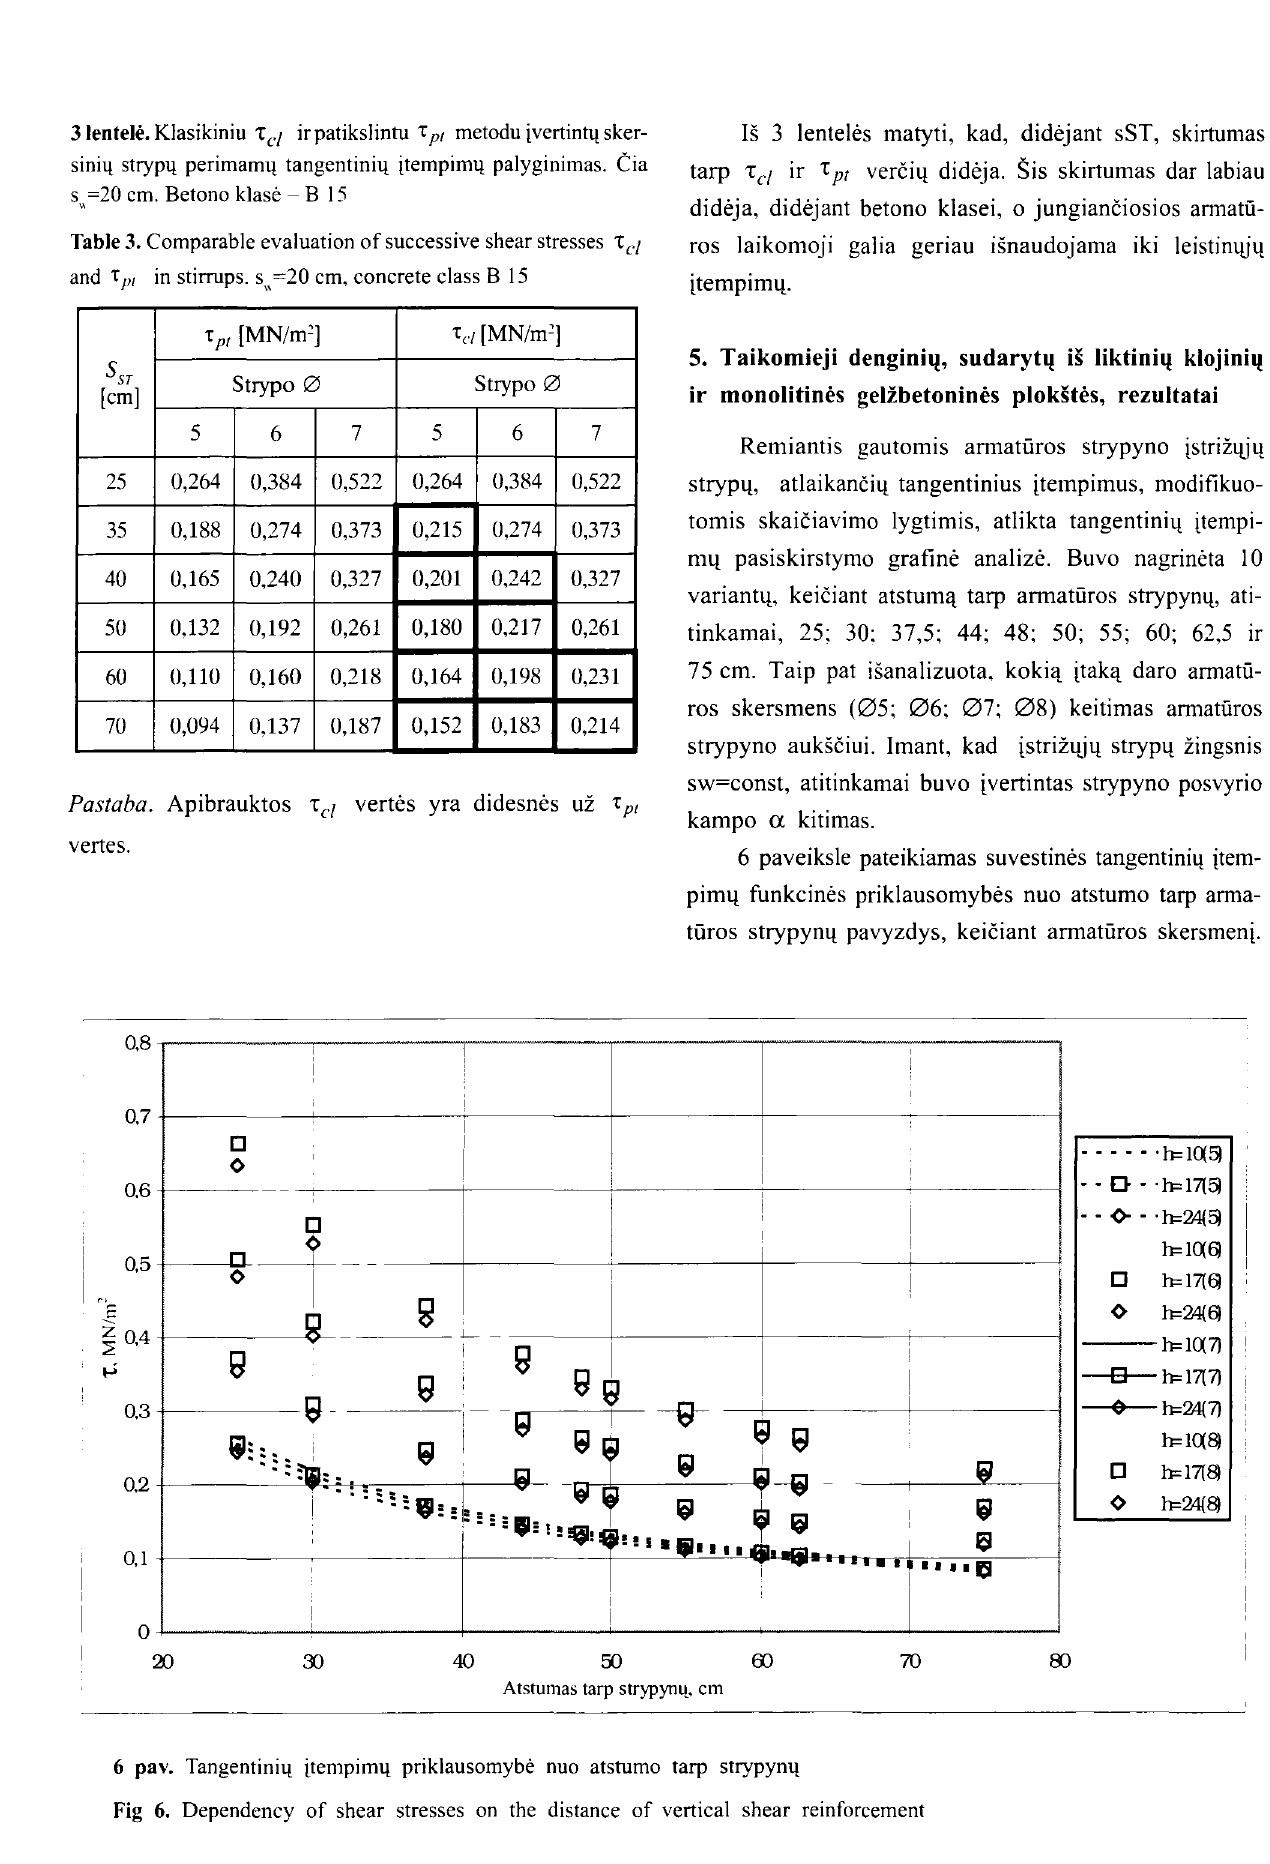
Fig 6. Dependency of shear stresses on the distance of vertical shear reinforcement